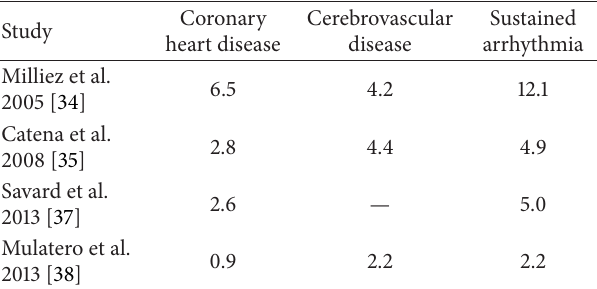
Table 1: Relative risk of cardiovascular events in patients with primary aldosteronism versus patients with essential hypertension. Coronary Cerebrovascular Sustained Study heart disease disease